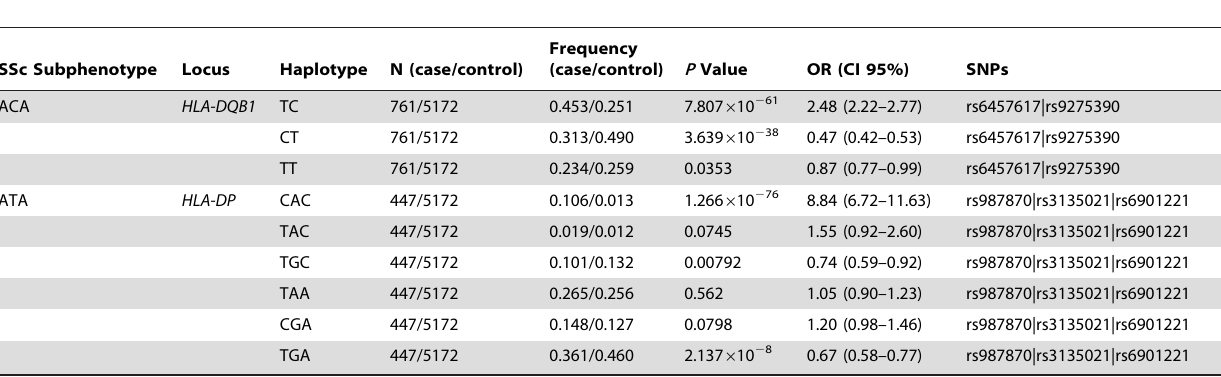
Table 3. Allelic combination analysis of the SNPs which are in the same association locus within the HLA region for the ACA and ATA positive subgroups of SSc